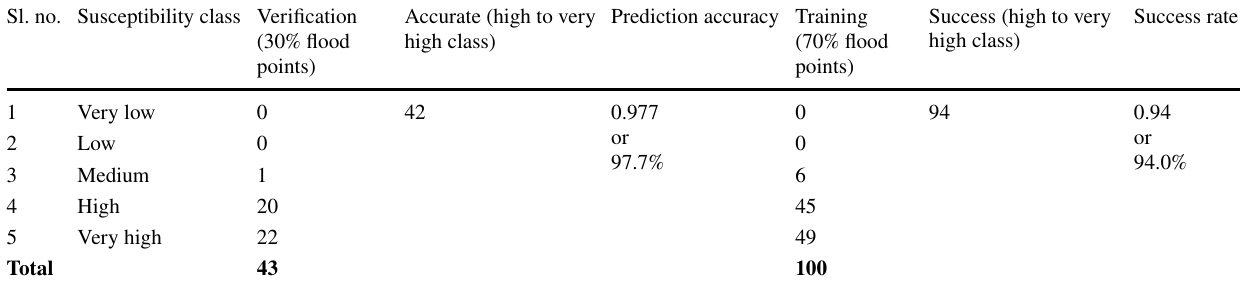
Table 4 Calculation of prediction accuracy and success rate for the flood susceptibility analysis Sl. no. Susceptibility class Verification (30% flood